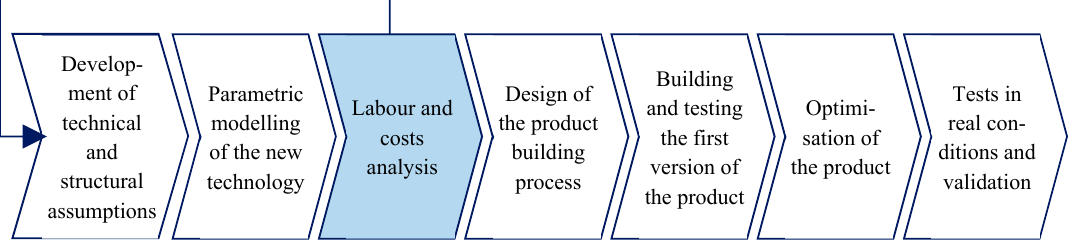
Figure 3. The PDP of automated lines for pet food packing. Source: own study.